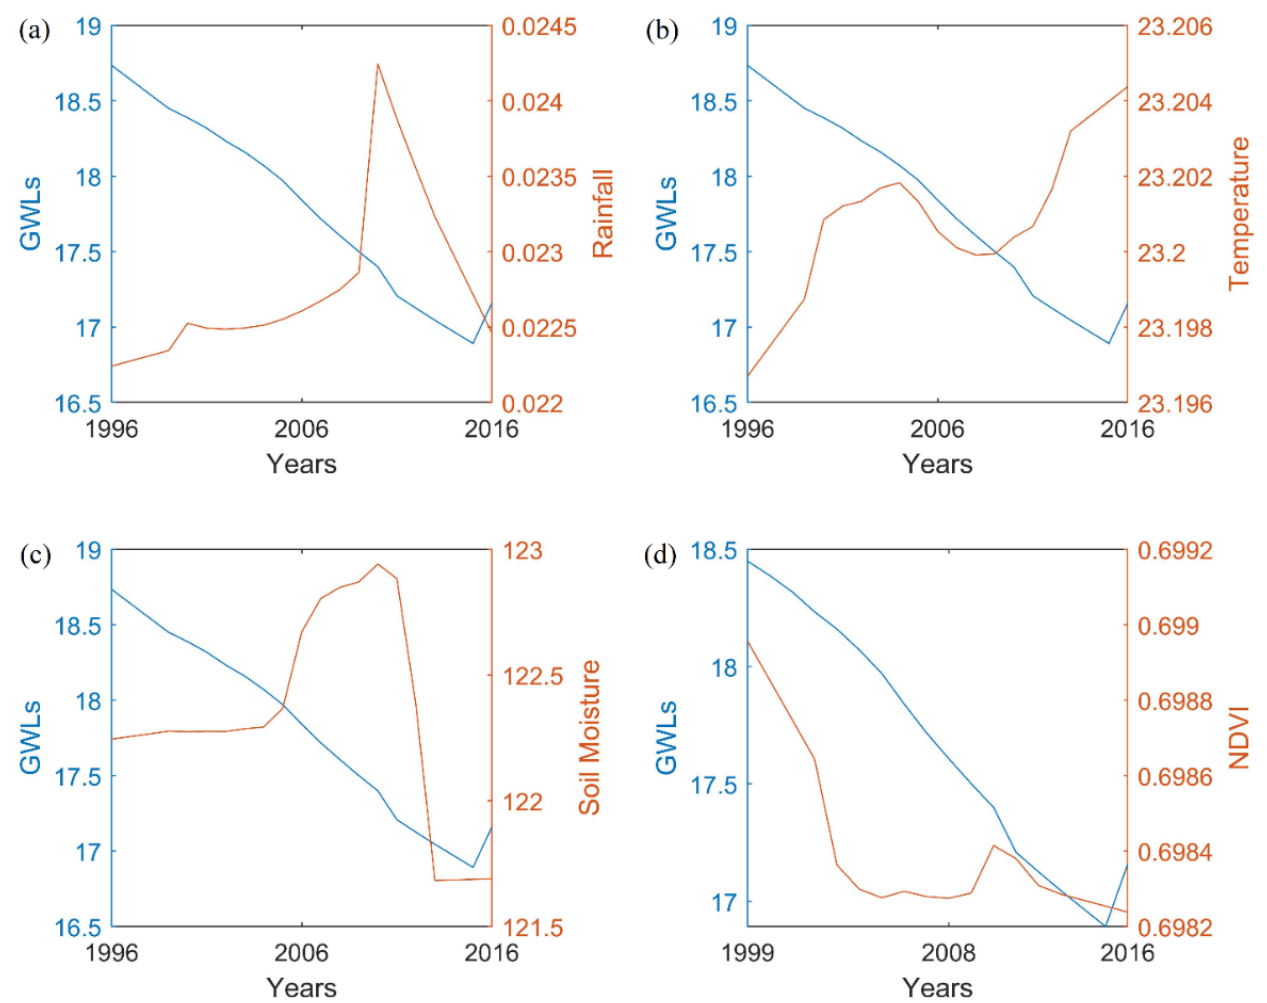
Figure 13. The January month groundwater levels of Poonkulam well location verses ( a ) Rainfall, ( b ) Temperature, ( c ) Soil Moisture, and ( d ) NDVI.